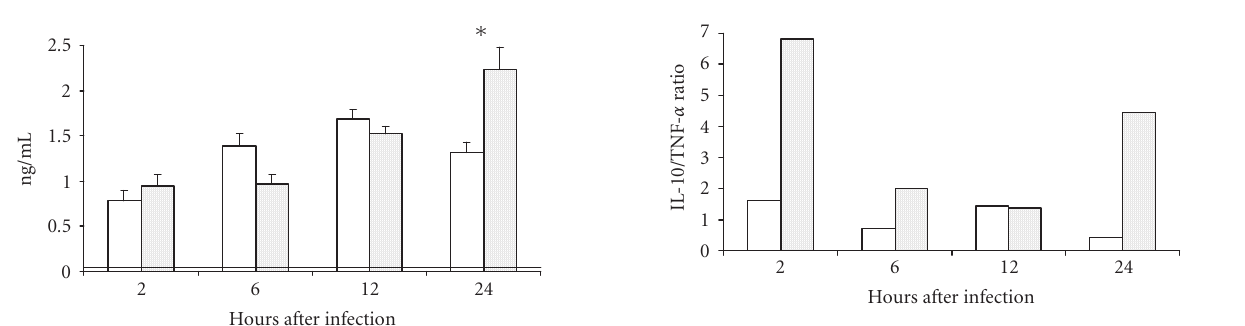
Figure 1: Plasma concentration of IL-10 in the blood of BALB/c mice protected with anti-LPS MAb Ru-O1 (gray bars) and unpro- tected mice (white bars) after the IP infection with 50 CFU of K pneumoniae Caroli (O1 : K2) at di ff erent time points. Results are expressed as mean values ± SEM ng/mL. Six animals in each group were infected. ∗ Above bars represents the statistical significance be- tween the groups at the level of P < . 02. Horizontal line represents the mean value of plasma IL-10 concentration in the blood of un- infected control mice.